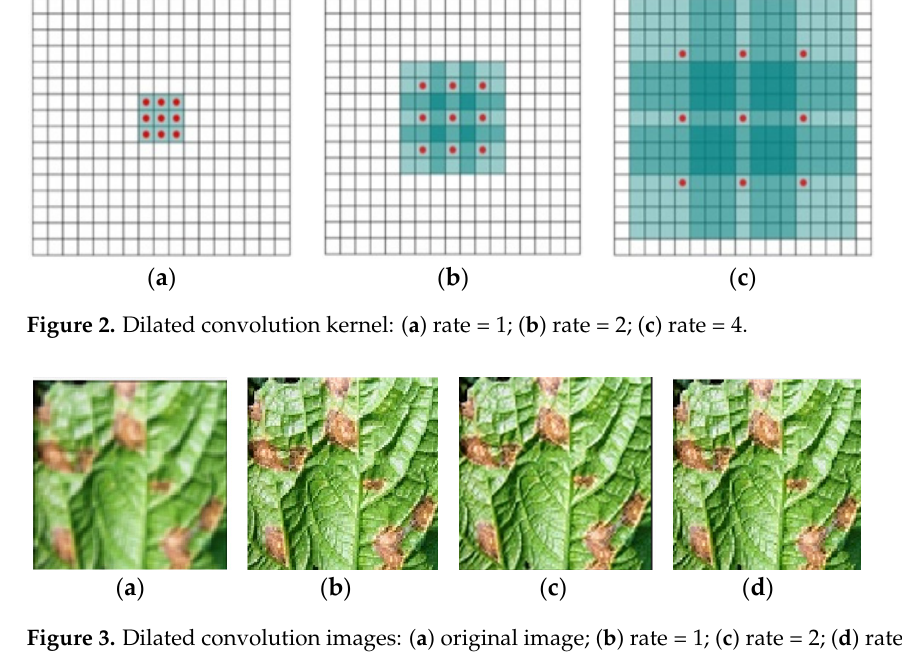
Figure 4. U-Net architecture. Encoding subnetwork consists of four down-sampling operations and middle-layer operations, and each down-sampling operation includes Conv 3 × 3, BN, ReLU, MaxPool 2 × 2, DEA, where Conv 3 × 3 is 3 × 3 convolution for feature extraction, BN is a batch normalization layer to alleviate the problem of gradient disappearance, ReLU is the acti- vation layer used to introduce nonlinear factors and accelerate network convergence, and MaxPool 2 × 2 is the maximum pooling layer of 2 × 2 to extract semantic information. Decoding subnetwork takes the output of the coding subnetwork as the input and carries out three upsampling operations, which are described as upconv 2 × 2 + Copy&crop + Conv 3 × 3 + BN + ReLU + DE module, where upconv 2 × 2 is a 2 × 2 upsampling convolu- tion operation used to restore the size and size of the feature maps, and copy&crop, namely skip connection, refers to integrate the rough features of the encoding subnetwork with the refined features of the decoding to better retain the spatial information and detail information of the original image and then improve the image accuracy. 2.4. Summarization The characteristics of the Residual block, dilated convolution and U-Net are summa- rized as follows. Residual blocks can increase the depth of the network, help solve the problems of gradient disappearance and gradient explosion, and ensure good performance while training deeper networks. When the network layer requires a large receptive field, but the computing resources are limited and cannot increase the number or size of convolution kernels, dilated convo- lution can be considered. Its advantages are that the receptive field can be increased with- out pooling information, so that each convolution output contains a large range of infor- mation. However, the dilated convolution may have a grid effect, that is, the convolution kernels are discontinuous; if only multiple 3 × 3 convolution kernels with dilation rate = 2